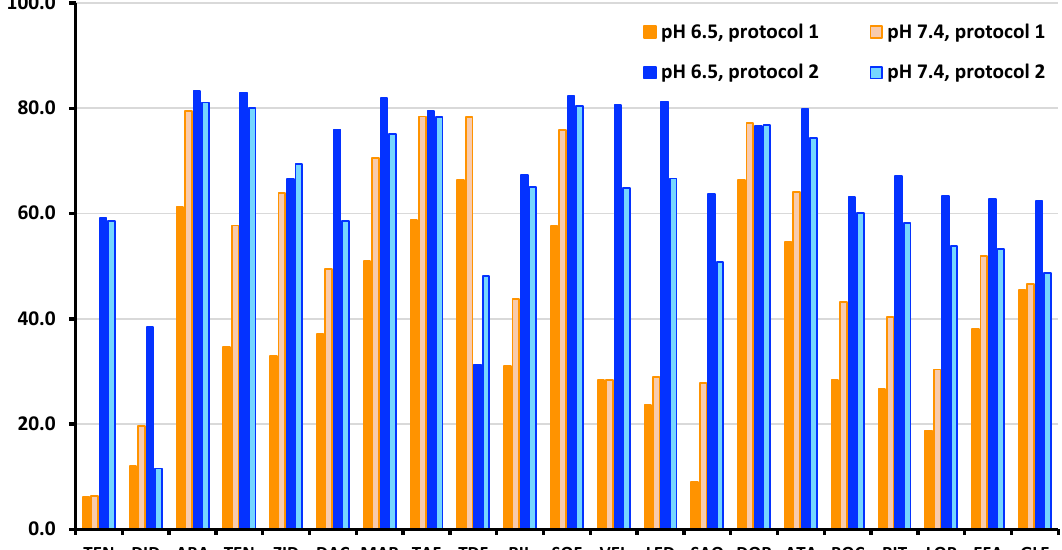
Figure 4. Comparison of two developed µ -SPE-PT sample preparation approaches based on AX/C 18 and CX/C 18 combina- tions of the sorbent and for two HBSS media of pH 6.5 and 7.4.